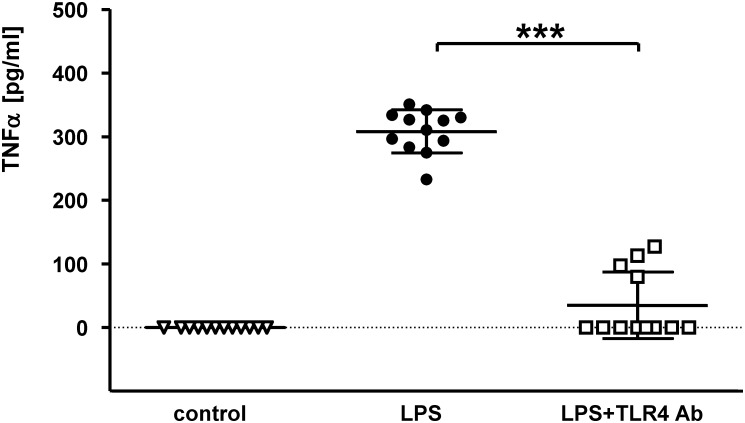
Anti-mouse TLR4/MD2 antibody clone MTS510 suppresses TLR4-mediated immune response in vitro.Murine RAW264.7 macrophage cells were incubated with (or without) anti-TLR4/MD2 (clone MTS510) antibody for 30min before incubation of the cells for 2 days with 10ng/ml lipopolysaccharide (LPS). TNFα concentration in the supernatant was determined by the use of a bioassay with the L929 reporter cell line and supernatant (1:200 dilution). TNFα concentration is indicated in pg/ml and was determined with 4 measurements of three separate biological samples in each group (control: incubation without LPS and MTS510 antibody; LPS: incubation with LPS only; LPS+TLR4: incubation with MTS510 antibody before stimulation with LPS), data are present with the mean ± SD (***p< 0.0001 as determined by Mann-Whitney U test).